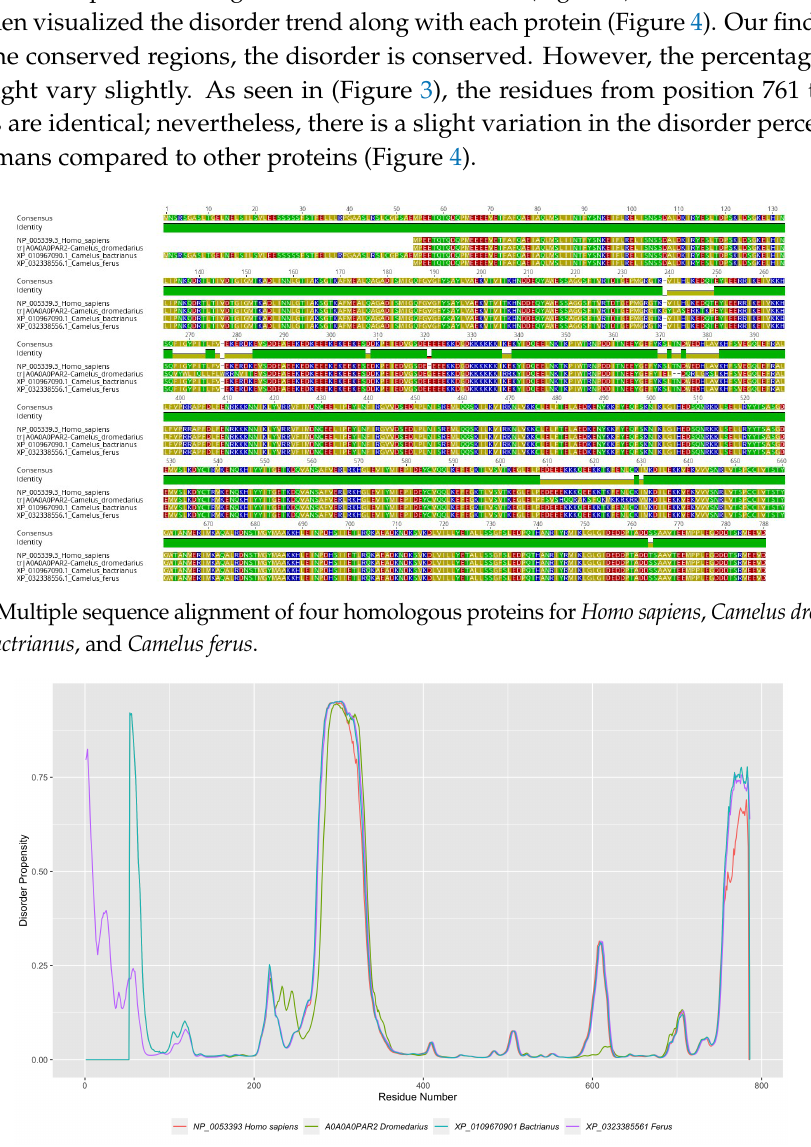
Figure 4. Disorder predispositions of four homologous proteins from Homo sapiens , Camelus dromedarius , Camelus bactrianus , and Camelus ferus